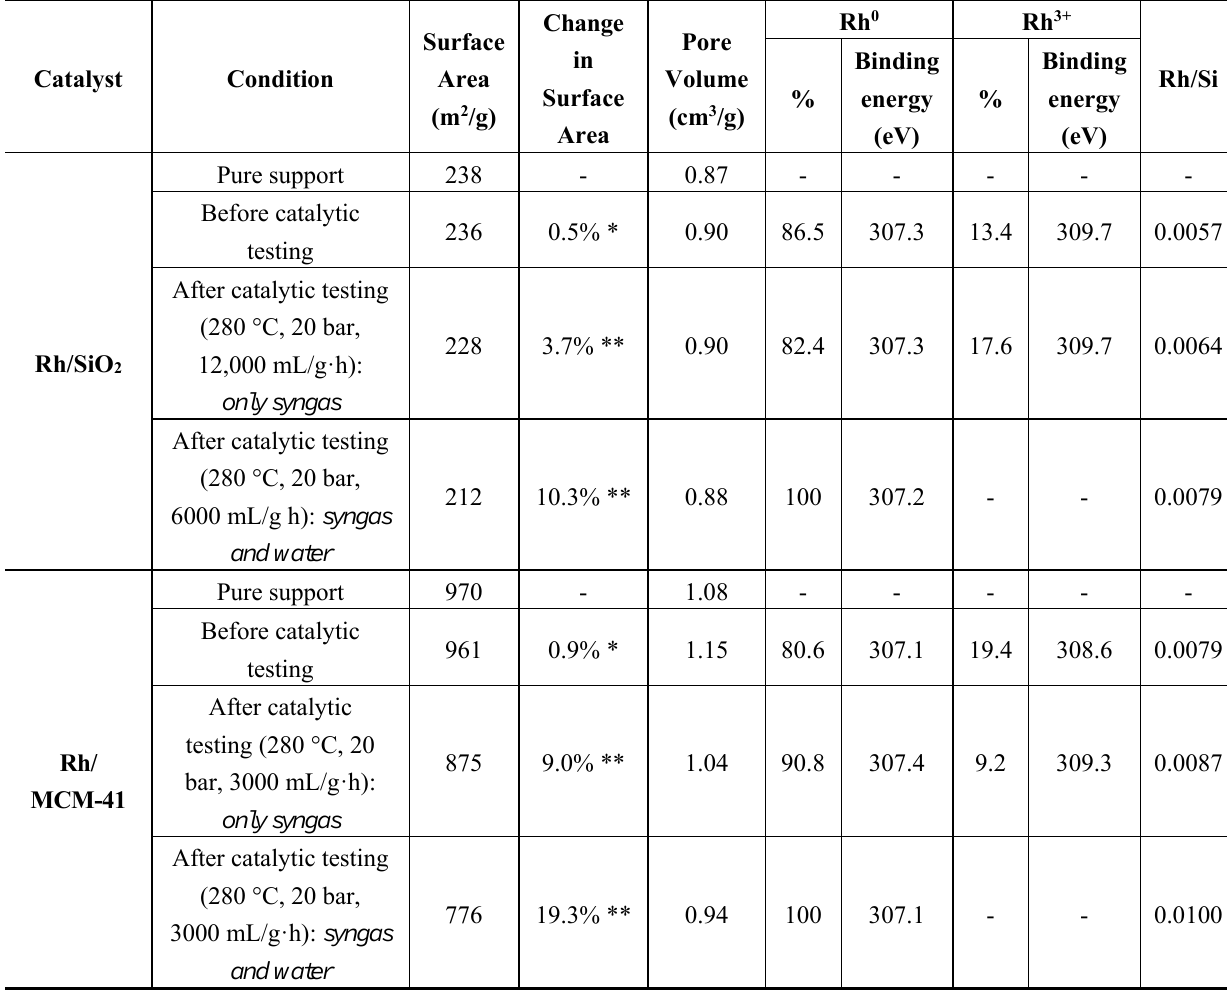
Table 2. N 2 -physisorption and XPS analyses of the Rh/SiO 2 and Rh/MCM-41 catalysts, before and after the catalytic